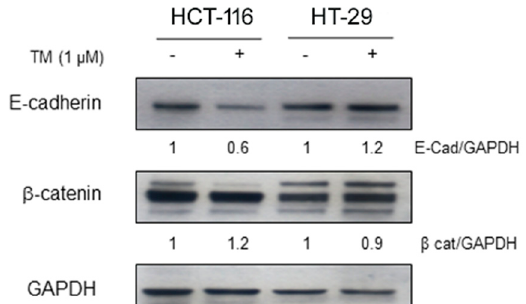
Figure 3. Copper chelation differently affects E-cadherin expression of colon cancer HT-29 cells bearing BRAF V600E mutation compared to HCT-116 cells carrying BRAF wt . HCT-116 and HT-29 were treated with TM (1 µ M) for 72 hours and then collected to evaluate specific anti- E-cadherin and β -catenin expression by immunoblot. Anti-GAPDH was used as loading control. Densitometry was performed using ImageJ software.